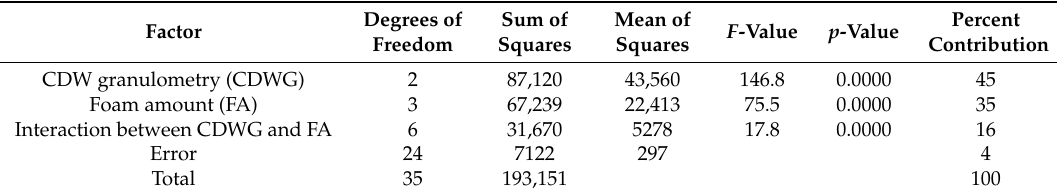
Table 5. Wet bulk density (WBD) ANOVA.